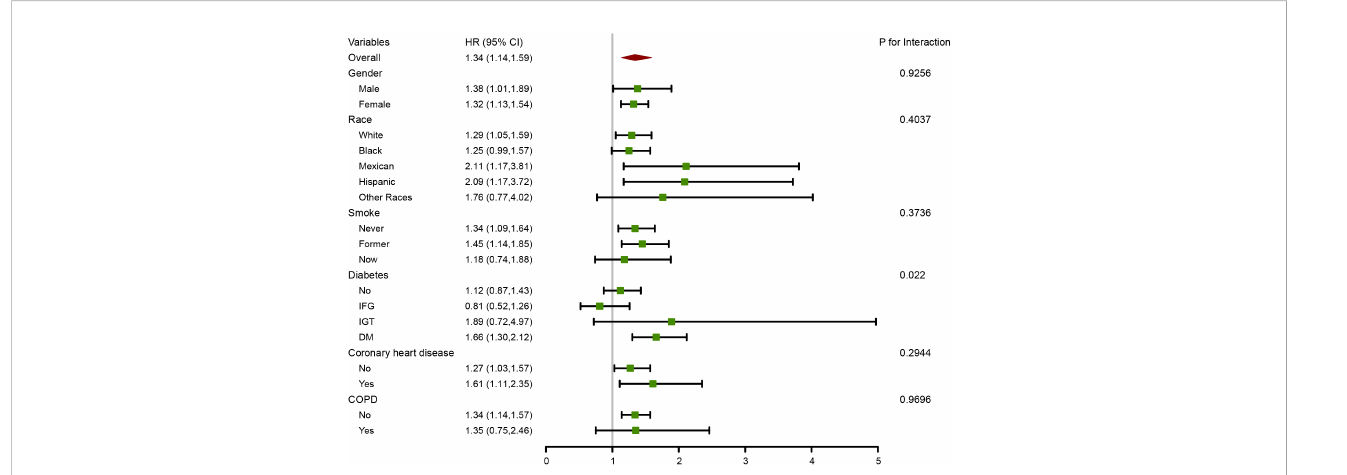
FIGURE 3 Forest plot for subgroup analysis of association between lnSII and all-cause mortality. Hazard ratios (HRs) were calculated using multivariate Cox regression models adjusted for the variables listed in the fully adjusted model except for the variable used for strati fi